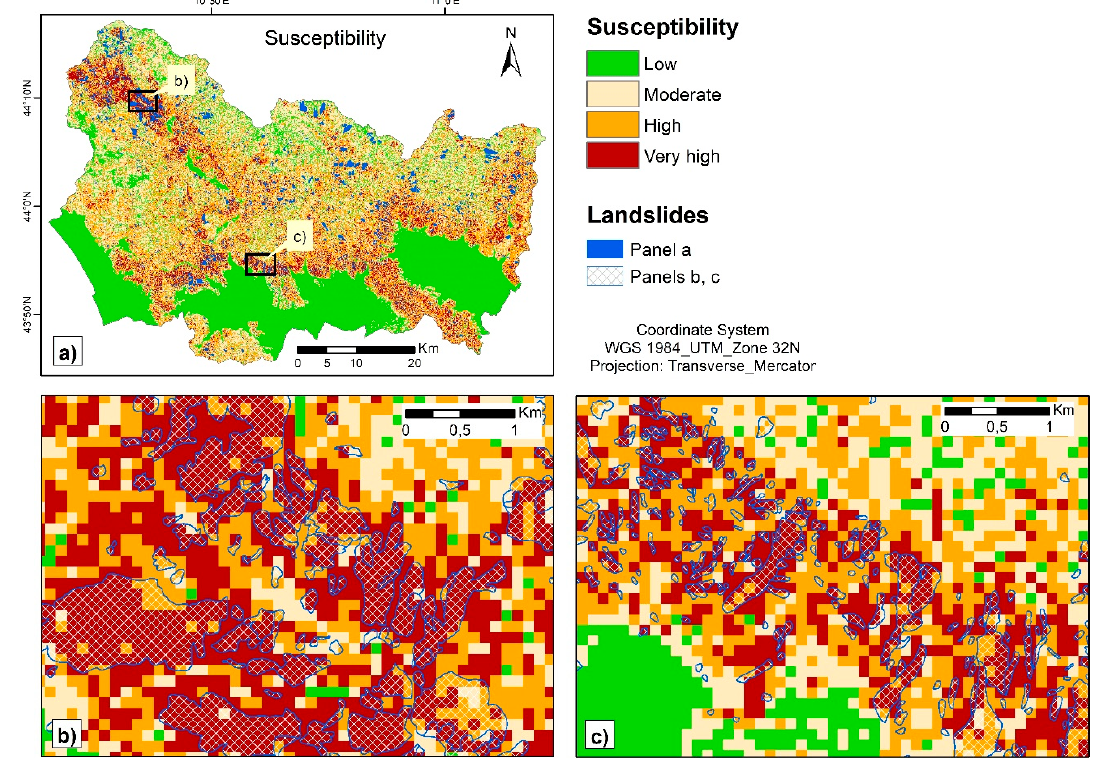
Figure 7. Landslide susceptibility map obtained with the SSA configuration and reclassified according to Jenks method, based on natural breaks: general view (panel a) and detailed view of areas of interest (panels b and c).